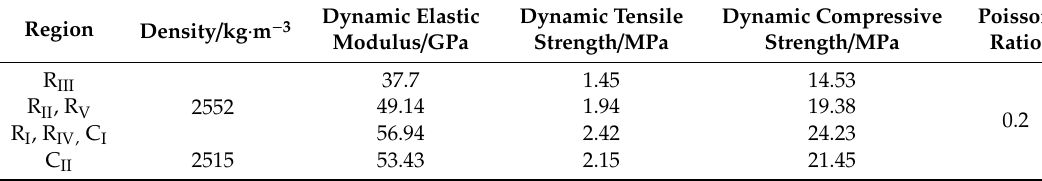
Table 1. Performance parameters of concrete material.